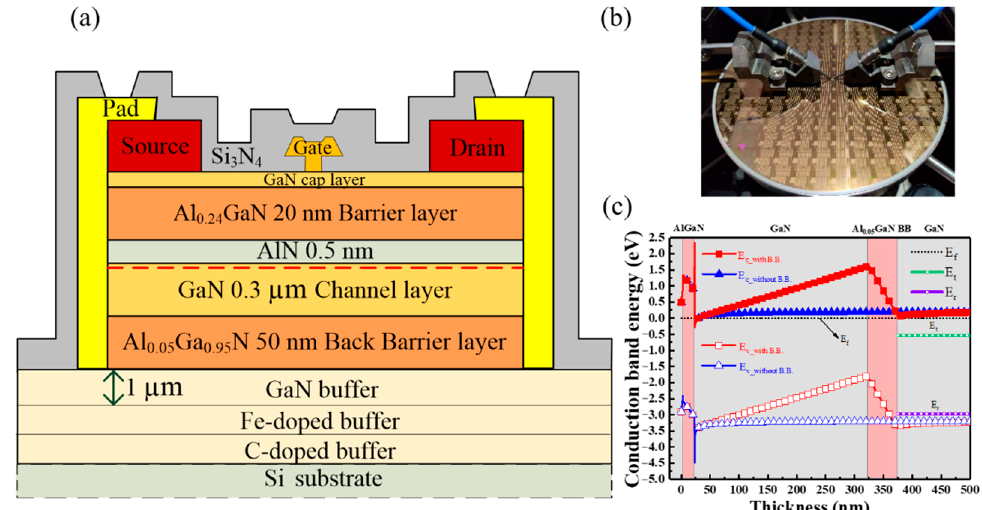
Figure 1. ( a ) Cross-sectional schematic of GaN on Si high-electron-mobility transistor (HEMT) and the ( b ) 6-inch GaN on the Si HEMT wafer. ( c ) The back barrier (BB) device conduction band energy simulation through 1-D Poisson distribution.